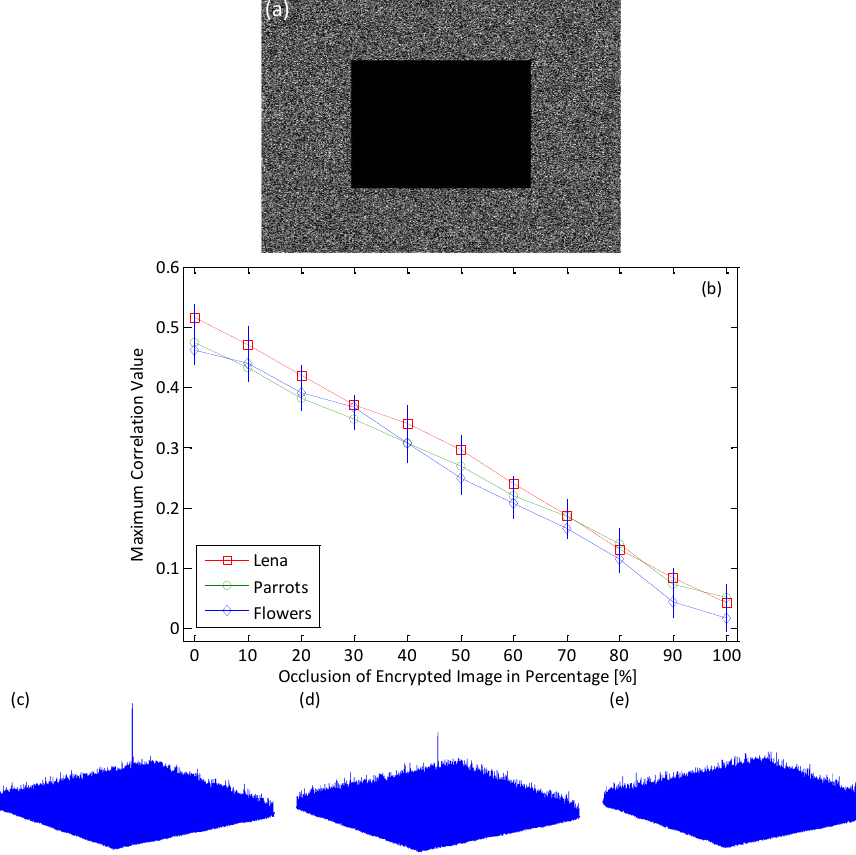
Figure 13. ( a ) Illustration of about 30% occlusion in encrypted image (values at occlusion area is set to be zero); ( b ) Maximum nonlinear correlation values with varying occlusion percentage in the encrypted image (Error bars represent ±1 standard deviation of the 50 time measurements, k = 0.3); ( c – e ) nonlinear correlation planes for true class Lena Bayer image when the encrypted image is occluded around 70%, 80% and 90% of the image area, respectively (k = 0.3, number of photons = 10 5